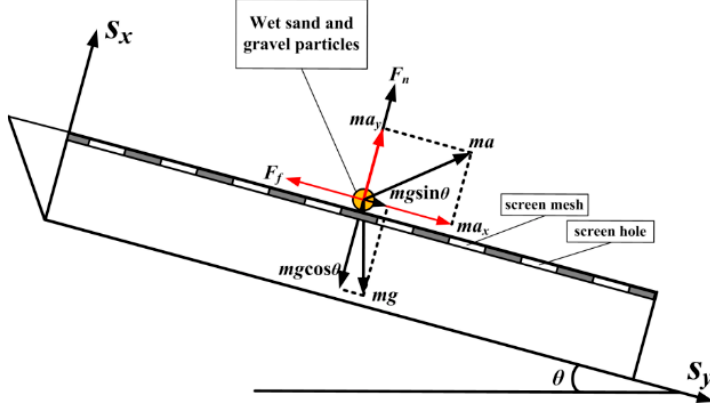
Figure 6. Force diagram showing the particles on the screen mesh.